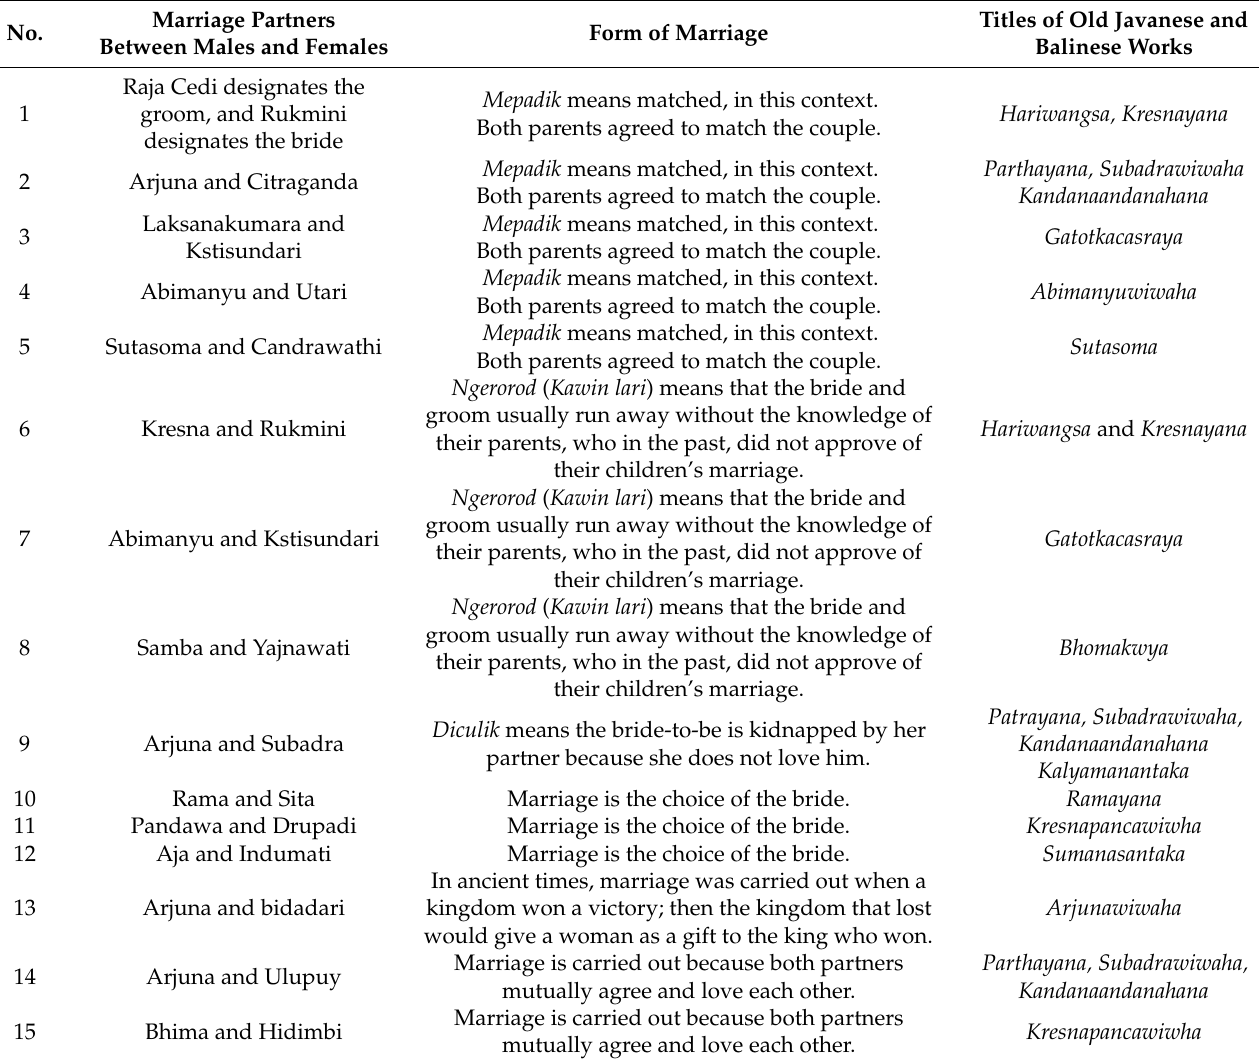
Table 1. The Patterns of Marriage in Hindu